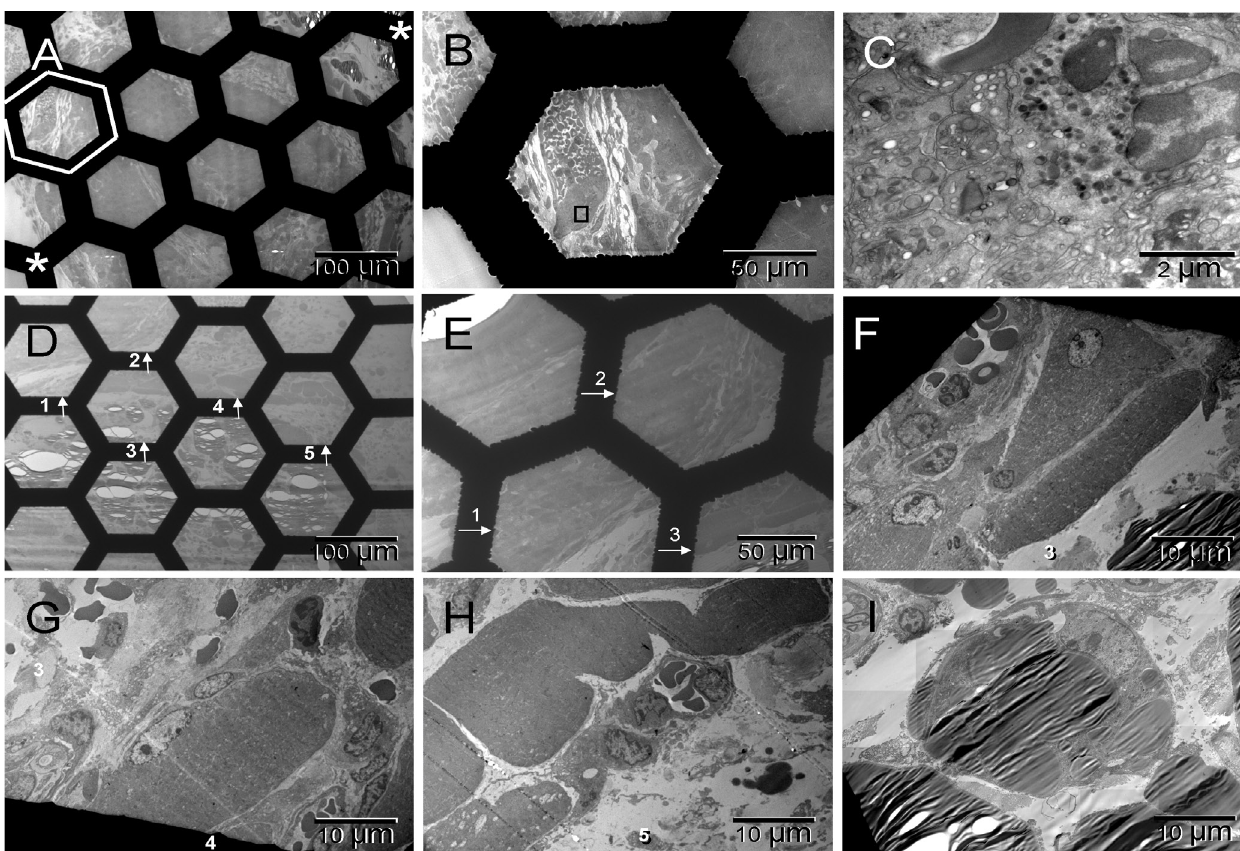
Figure 5. Histomorphology of the spheroid-derived tumors and the surrounding host tissues. The stars in [ A ] mark edges of the tumor facing glass of the chamber and the host tissues: muscles and fat underlying the host’s dorsal skin (lower left and upper right respectively). The field framed with white hexagon and enlarged in [ B ] contains the capsular vaso-mimicry separated from the larger tumor mass with a multi-cellular layer of fibroblasts. Fragments of that field are shown at higher magnifications in Figure 1 [ I ] and here in panel [ C ] where a cluster of platelets can be recognized next to a neutrophil (left and right sides of the image, respectively). A larger region of the host tissues between the tumor and skin is shown in [ D ]. Fields 1–3 are enlarged in [ E ]. [ F – H ] focus on muscle cells from fields 3–5 accompanied by vessels, nerve [ G ] and lipid droplets [ F & H ]. The adipocyte in [ I ] is from a region not shown at low magnification. None of the hexagonal fields enclosed by the grid bars was completely filled with the tumor cells indicating that the size of individual nodules roughly matched the oxygen diffusion range (100–200 µm 58